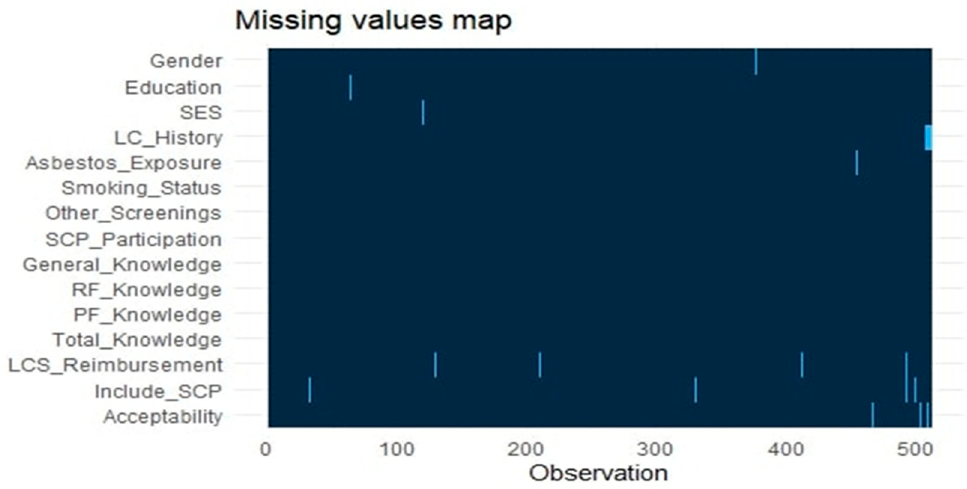
Figure A1. Map of the missing values present in our complete dataset (n = 511) with the variables of interest.